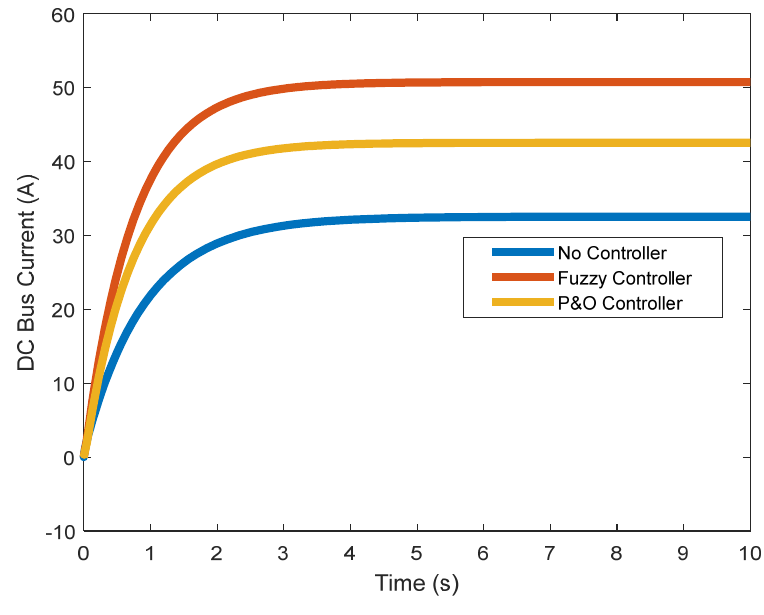
Figure 14. DC link current.